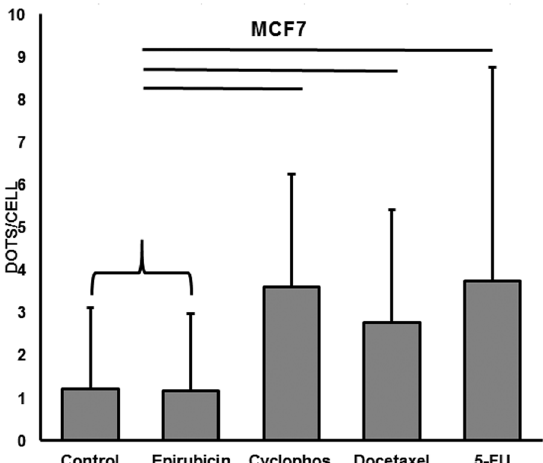
Figure 3. Quantification of autophagy in MCF7 cells. Mean and SD of cytoplasmic dot signals of LC3b in 100 cells from each MCF7 culture. Line indicates p < 0.05 (Mann-Whitney test). Significant differences were observed between the control and cyclophosphamide, docetaxel, 5-FU or epirubicin treated